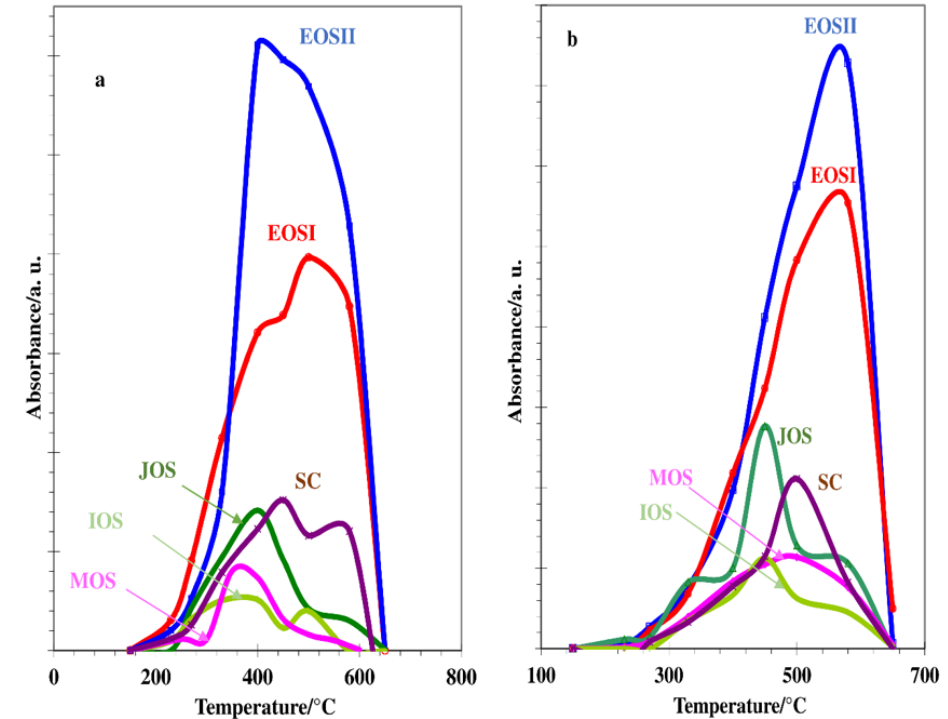
Figure 4. Emission profiles of methane (3014 cm − 1 ) ( a ) and chlorobenzene (742 cm − 1 ); ( b ) emitted in the thermooxidative decomposition of oil shale samples (10 °C min − 1 ).